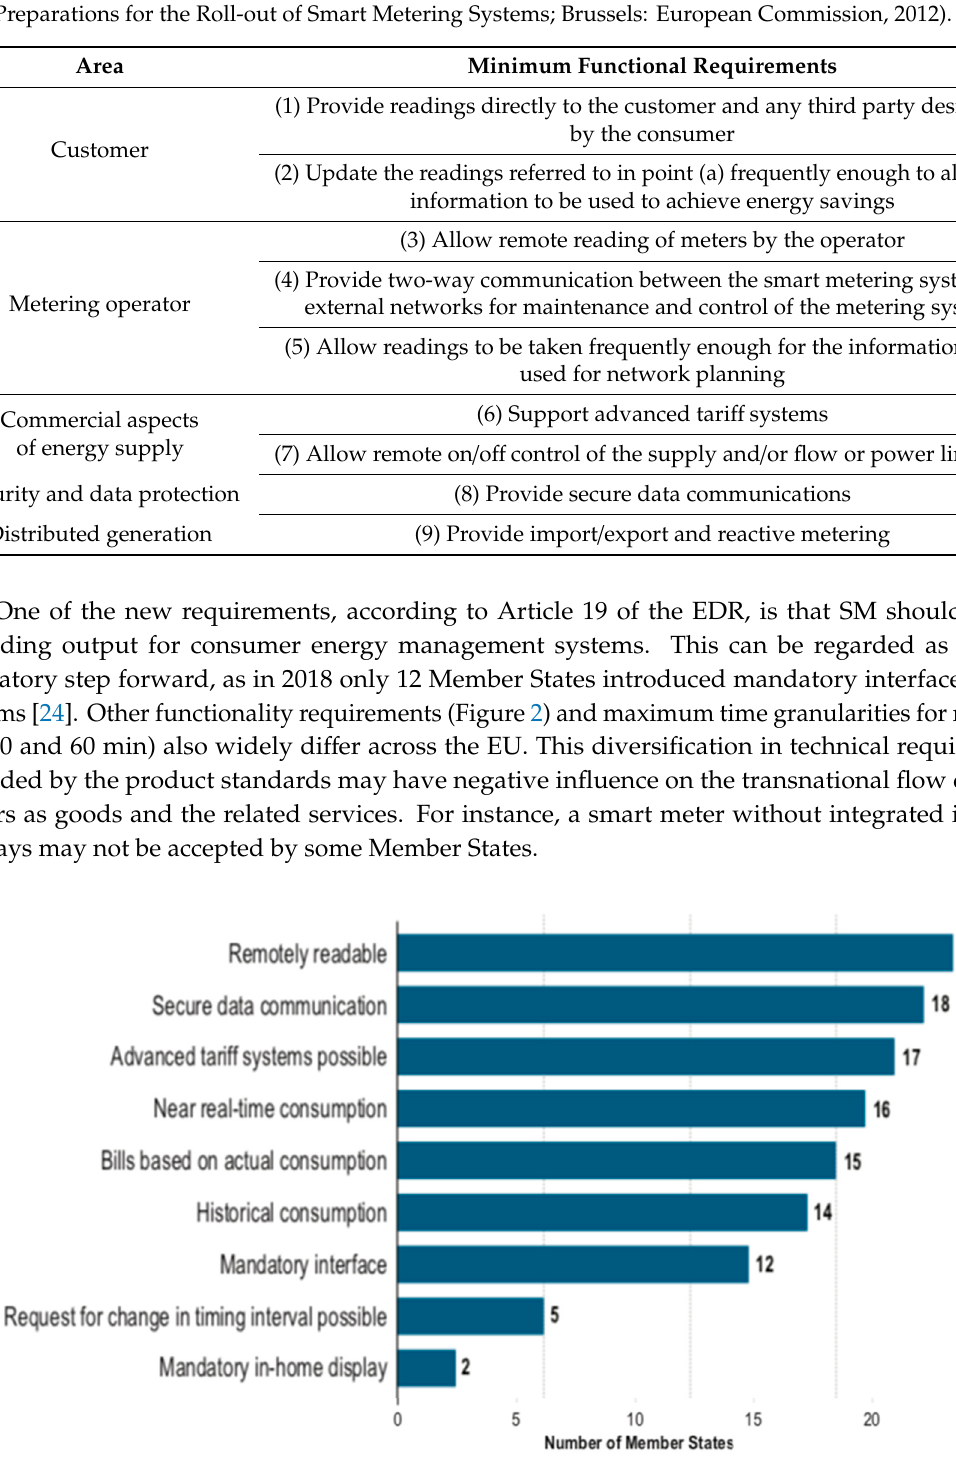
Figure 2. Most adopted legal requirements for smart meters in EU MSs—2017 (number of MSs). Reproduced with permission from the Agency for the Cooperation of Energy Regulators and the Council of European Energy Regulators, ACER and CEER, Annual Report on the Results of